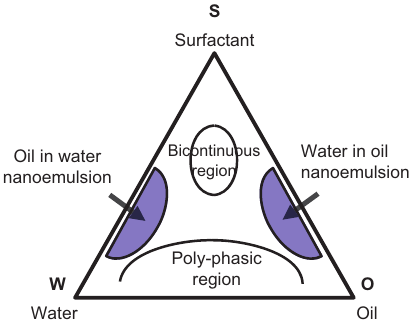
Figure 2 The schematic phase diagram of a water-oil-surfactant ternary system. The shaded areas are regions where self-assembled nanoemulsions are